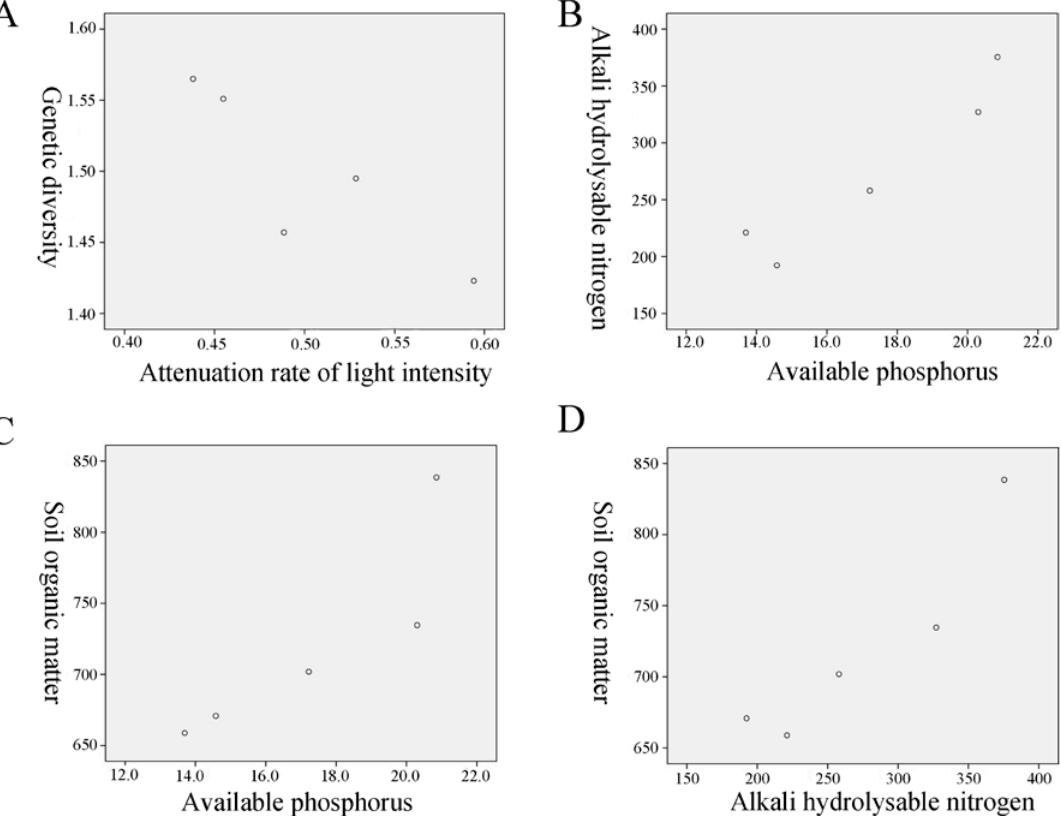
Fig. 3. Correlation between genetic diversity and attenuation rate of light intensity (A), content of alkali hydrolysable nitrogen and available phosphorus (B), soil organic matter and available phosphorus content (C), as well as soil organic matter and alkali hydrolysable nitrogen content